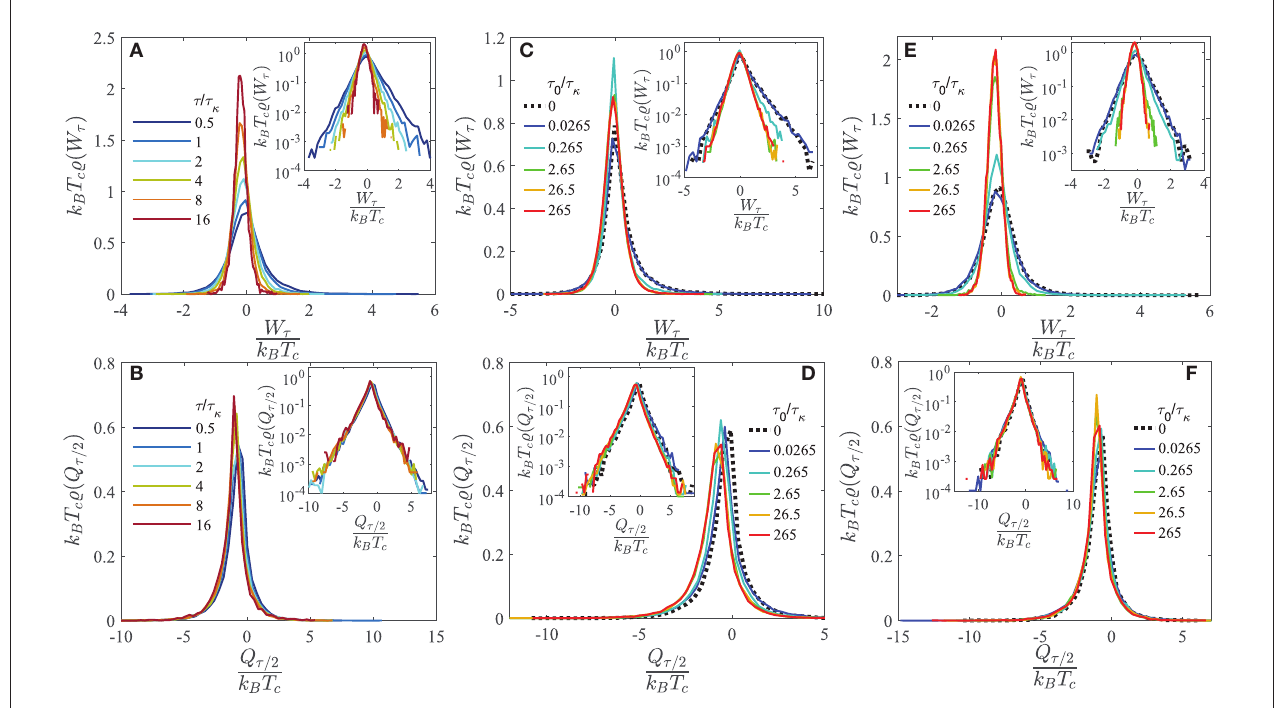
FIGURE 2 | (A) Probability density function of the work W τ , and (B) the heat Q τ/ 2 , for a Brownian Stirling engine in contact with a viscoelastic fluid bath with relaxation time τ 0 2.65 τ κ , for different values of the cycle time τ . (C) Probability density function of the work W τ , and (D) the heat Q τ/ 2 , for a Brownian Stirling engine during a = τ κ , in contact with viscoelastic fluid baths with the same zero-shear viscosity η 0 cycle of duration τ = of magnitude (solid lines). (E) Probability density function of the work W τ , and (F) the heat Q τ/ 2 , for a Brownian Stirling engine during a cycle of duration τ contact with viscoelastic fluid baths with the same zero-shear viscosity η 0 (C–F) , the dotted lines represents the corresponding curves for a Brownian engine in a Newtonian fluid ( τ 0 semilogarithmic representations of the main